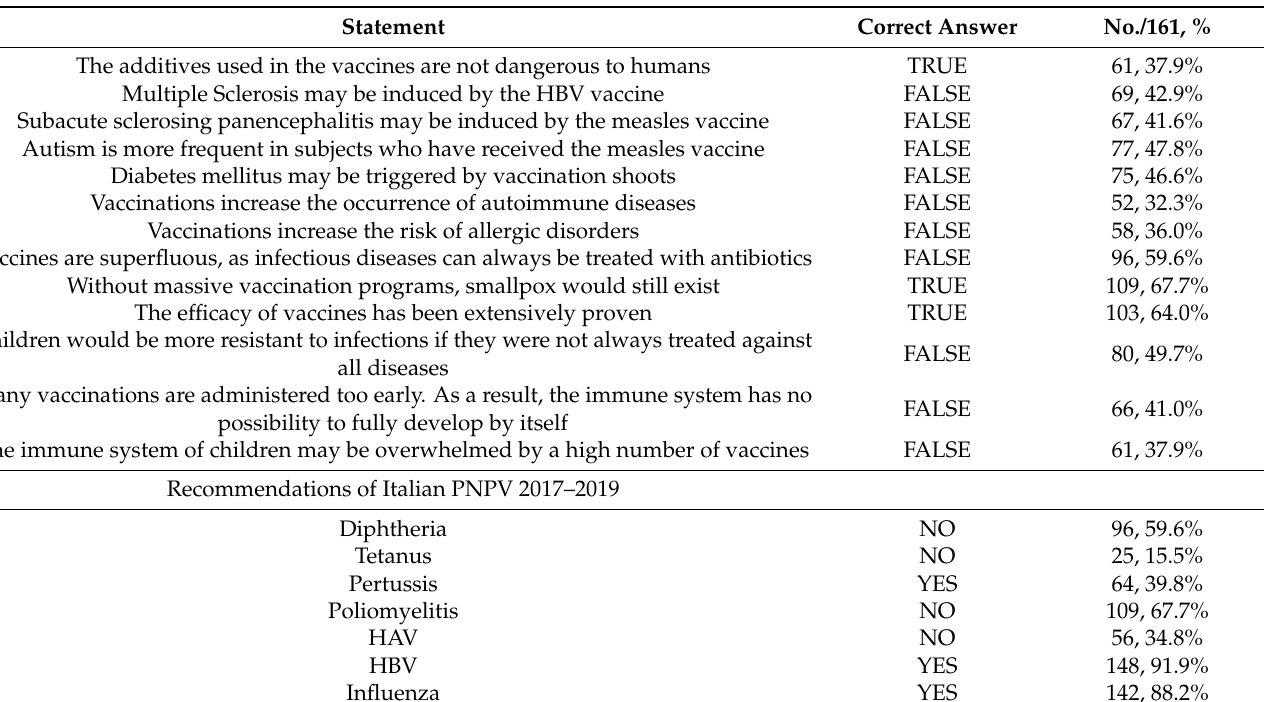
Figure 2. Density plots for knowledge scores, calculated for general knowledge on vaccinations (average: 46.5% ± 32.4, range 0–100; median 46.2%) ( a ) and on the understanding of the National Immunization Prevention Plan 2017–2019 (PNPV) (average: 54.1% ± 11.8, range 28.6–85.7; median 50.0%) ( b ). Dotted lines report the respective median values. Table 2. Assessment of general knowledge on immunizations, and awareness of specific recom- mendations (National Immunization Prevention Plan 2017–2019, PNPV 2017–2019) for healthcare workers among 161 first responders participating in the survey (Province of Parma, 2018). Notes: Vaccine Prevention